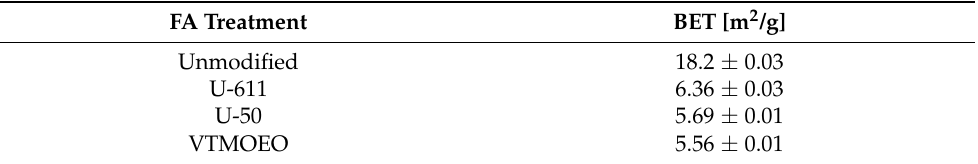
Table 4. BET specific surface area (SSA) of unmodified and silanized virgin fly